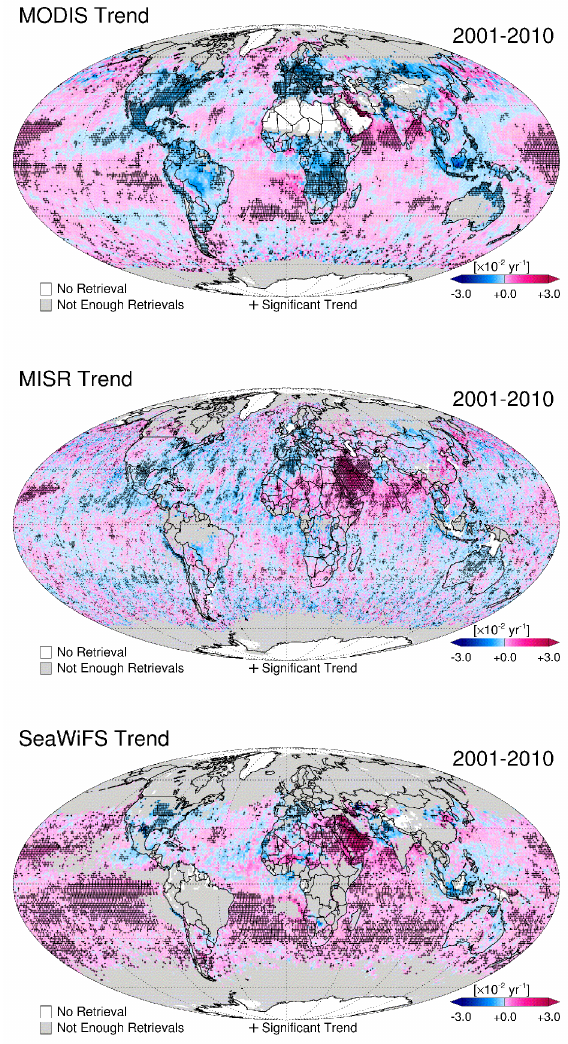
Figure 2. Linear trend between 2001 and 2010 in 10 − 2 year − 1 from different satellite instrument. The gray area means that less than six observations for each year were present, while white area means that not retrieval is present. Locations with trend significant at the 95% level are covered with the +